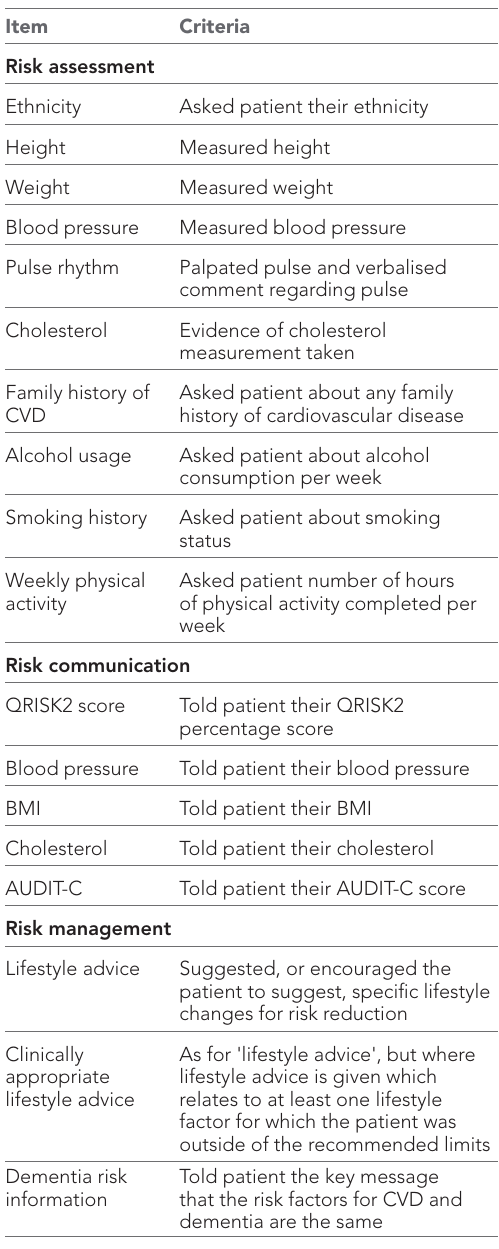
Table 1 NHS Health Check fidelity